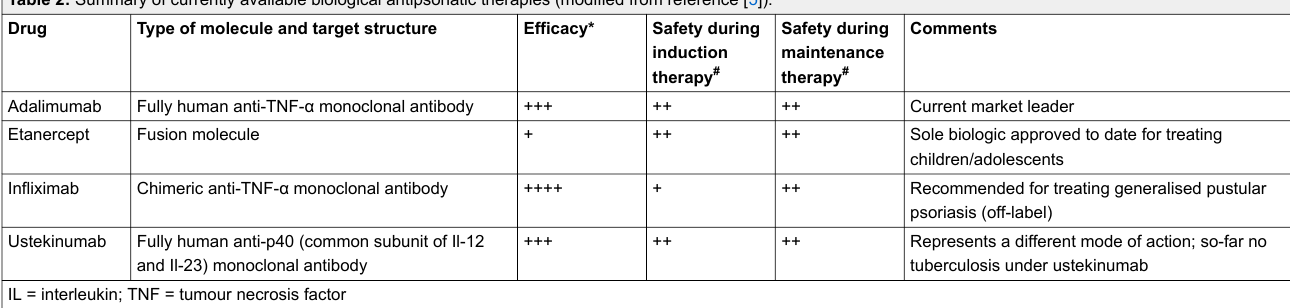
Table 2: Summary of currently available biological antipsoriatic therapies (modified from reference [5]). Drug Type of molecule and target